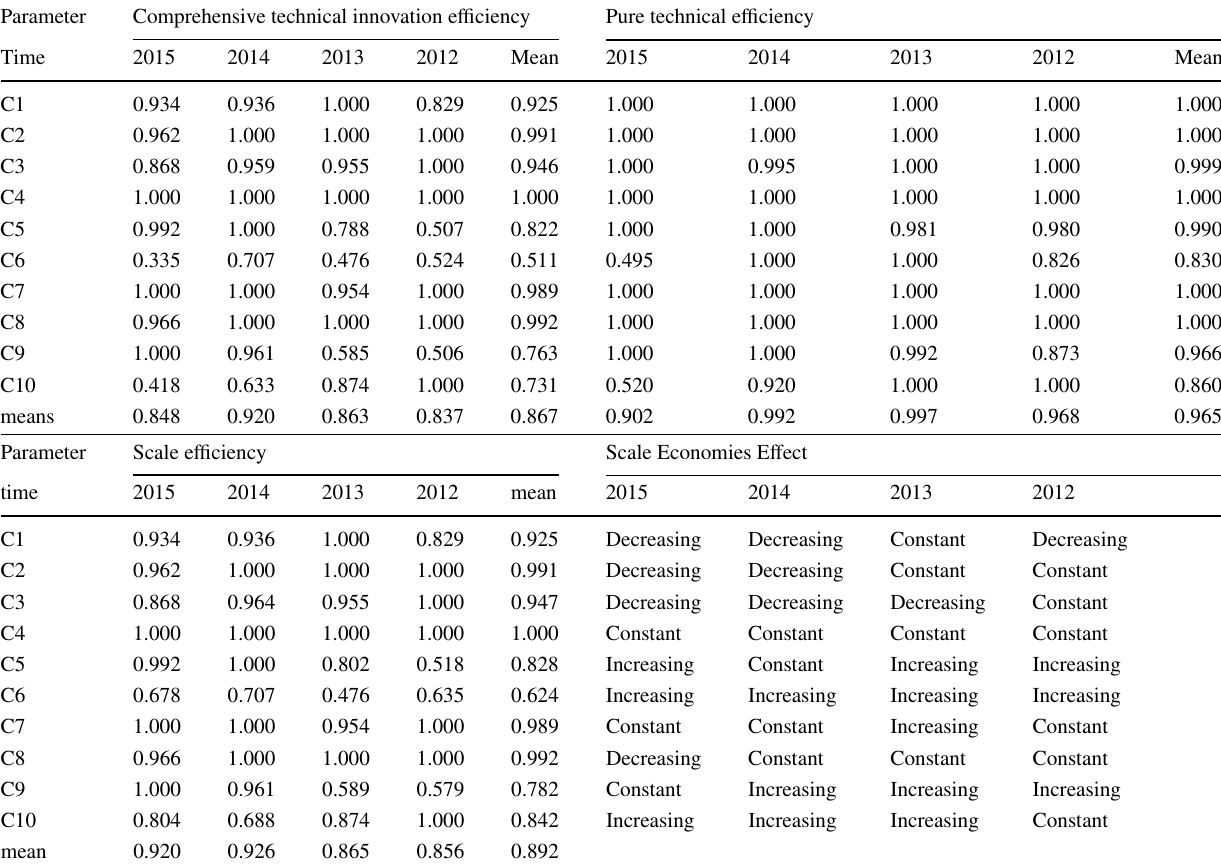
Table 2 Technical Innovation Efficiency of 10 Oil Production Plants under BCC Model from 2012 to 2015 Parameter Comprehensive technical innovation efficiency